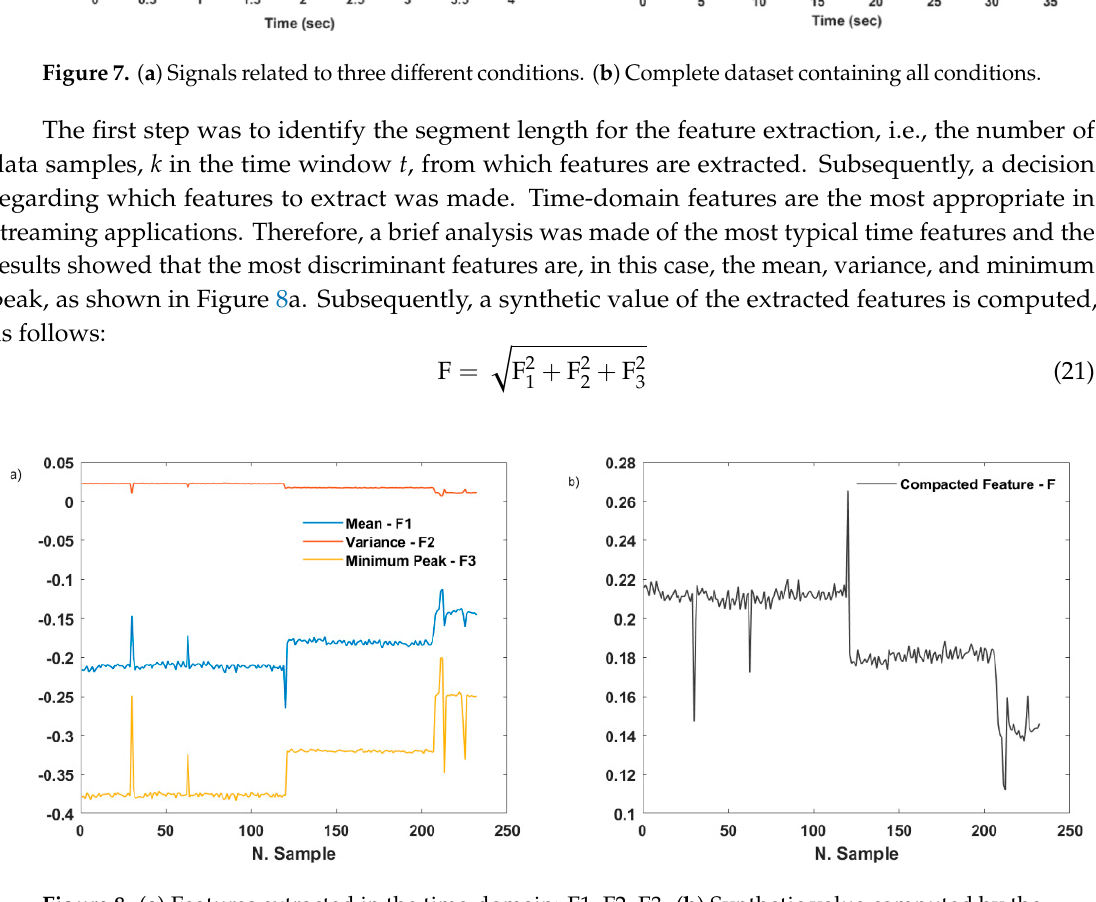
Figure 7. ( a ) Signals related to three different conditions. ( b ) Complete dataset containing all conditions.